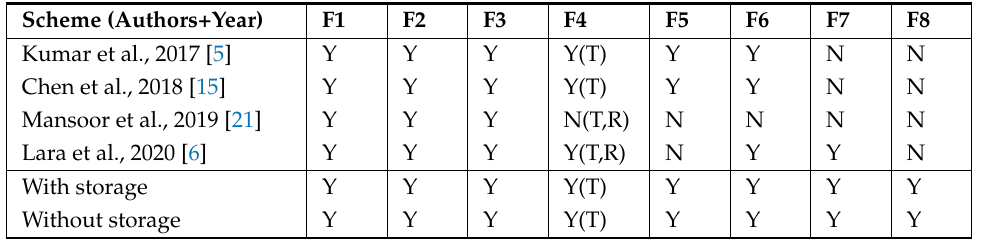
Table 2. Comparison of security strength with related and recent literature with respect to the